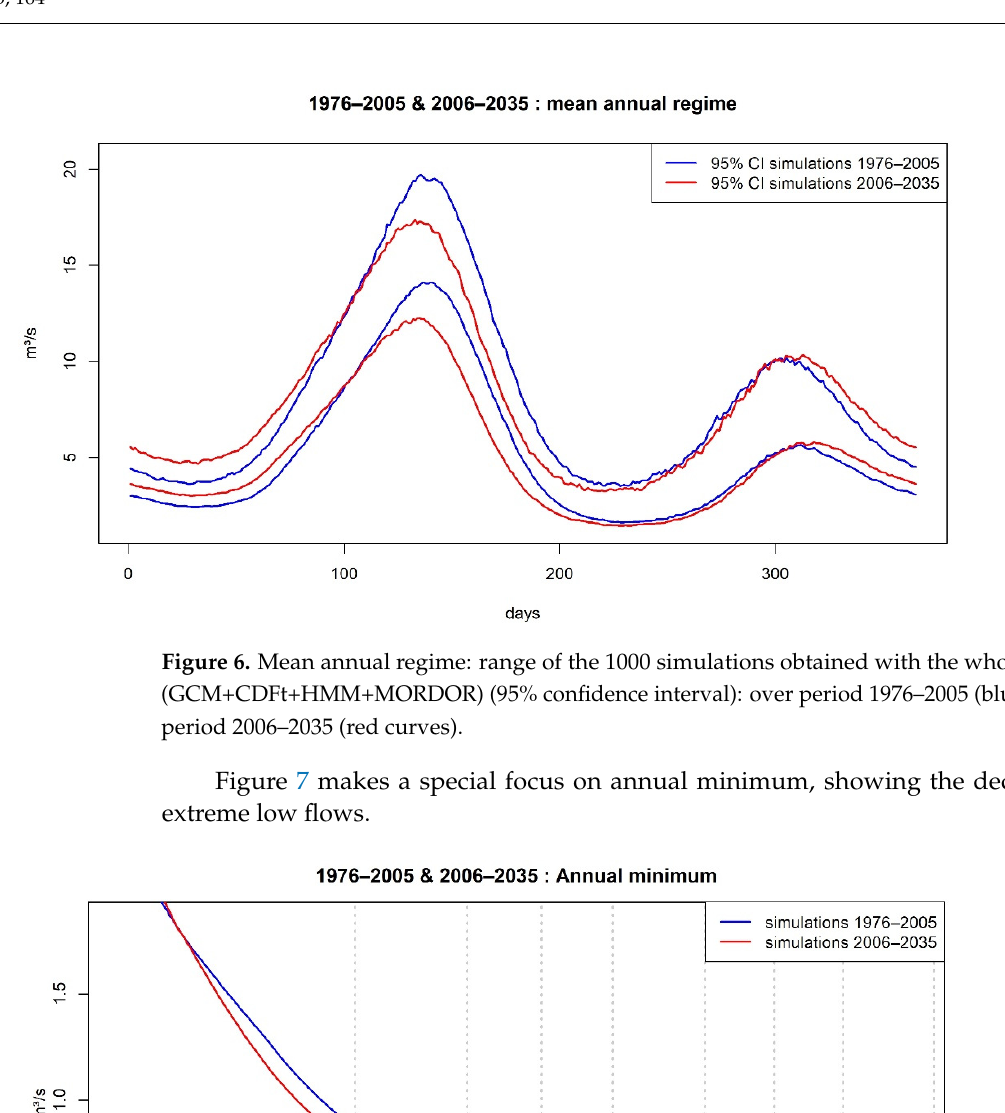
Table 2. Different return levels for low flows for each sub-period with their 70% bootstrap confi- dence interval in brackets.